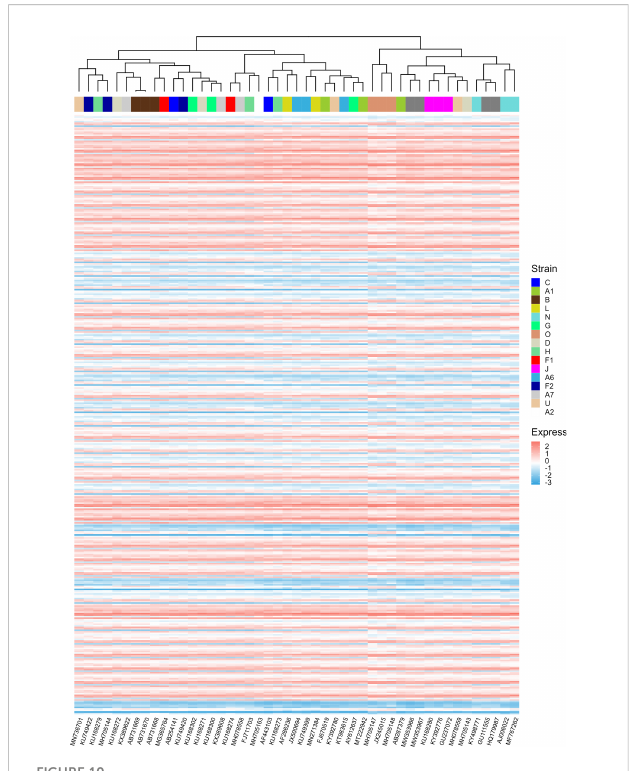
FIGURE 10 The hierarchical clustering of different HIV-1 strains based on their nine ORFs ’ standardized CAIs in all unstimulated cell types/subtypes/ large groups from bulk RNA-seq datasets and scRNA-seq datasets. Only strains whose CAIs of all ORFs were calculated were involved in the analysis. Each row represents an ORF in a speci fi c cell type/ subtype/large group and each column represents an HIV-1 strain.